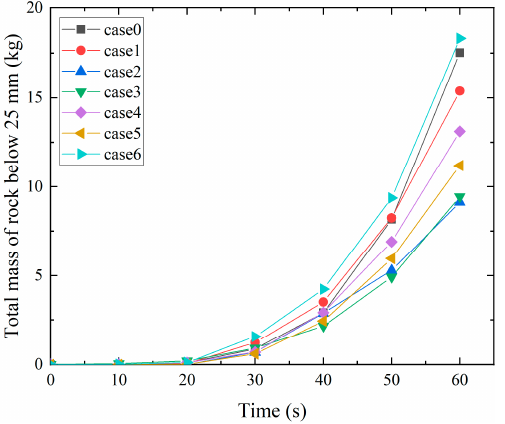
Figure 8. Breakage effect of mixed parameter.